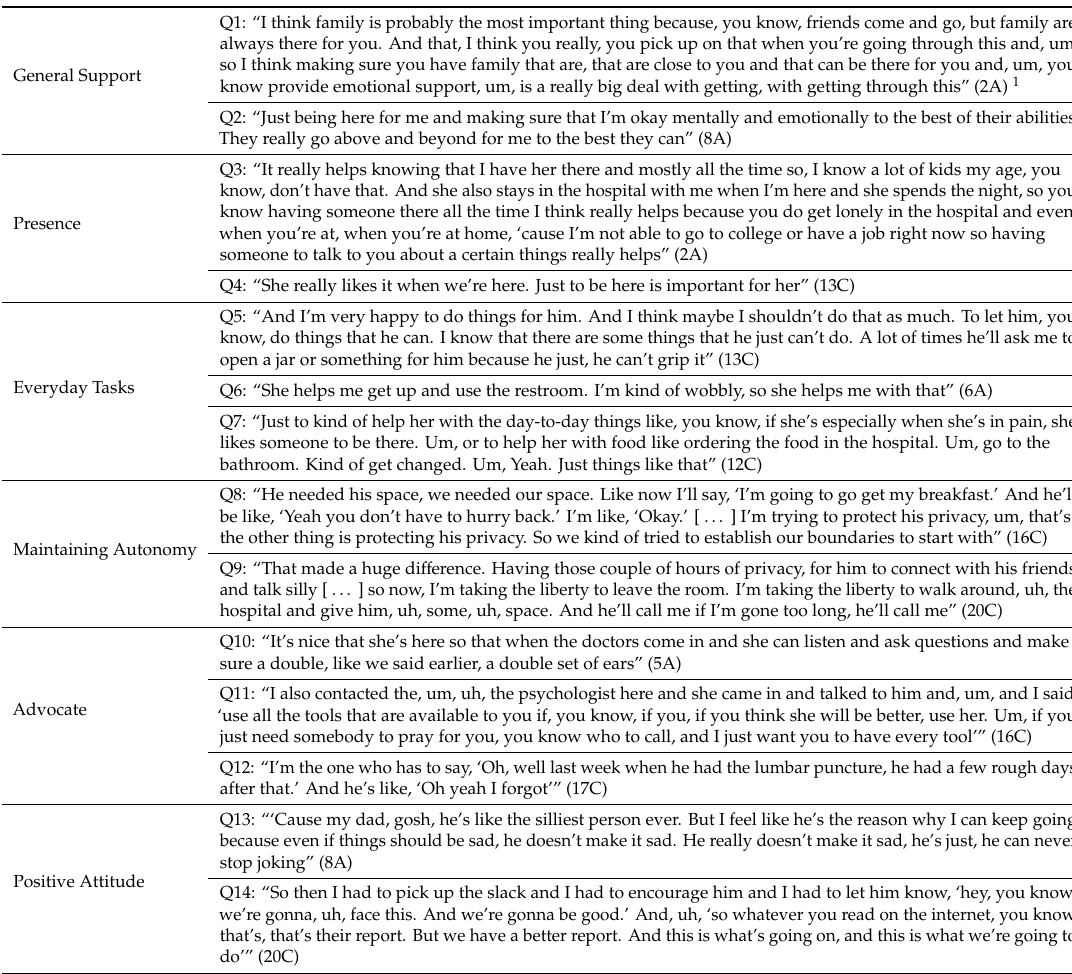
Table 3. Family support.